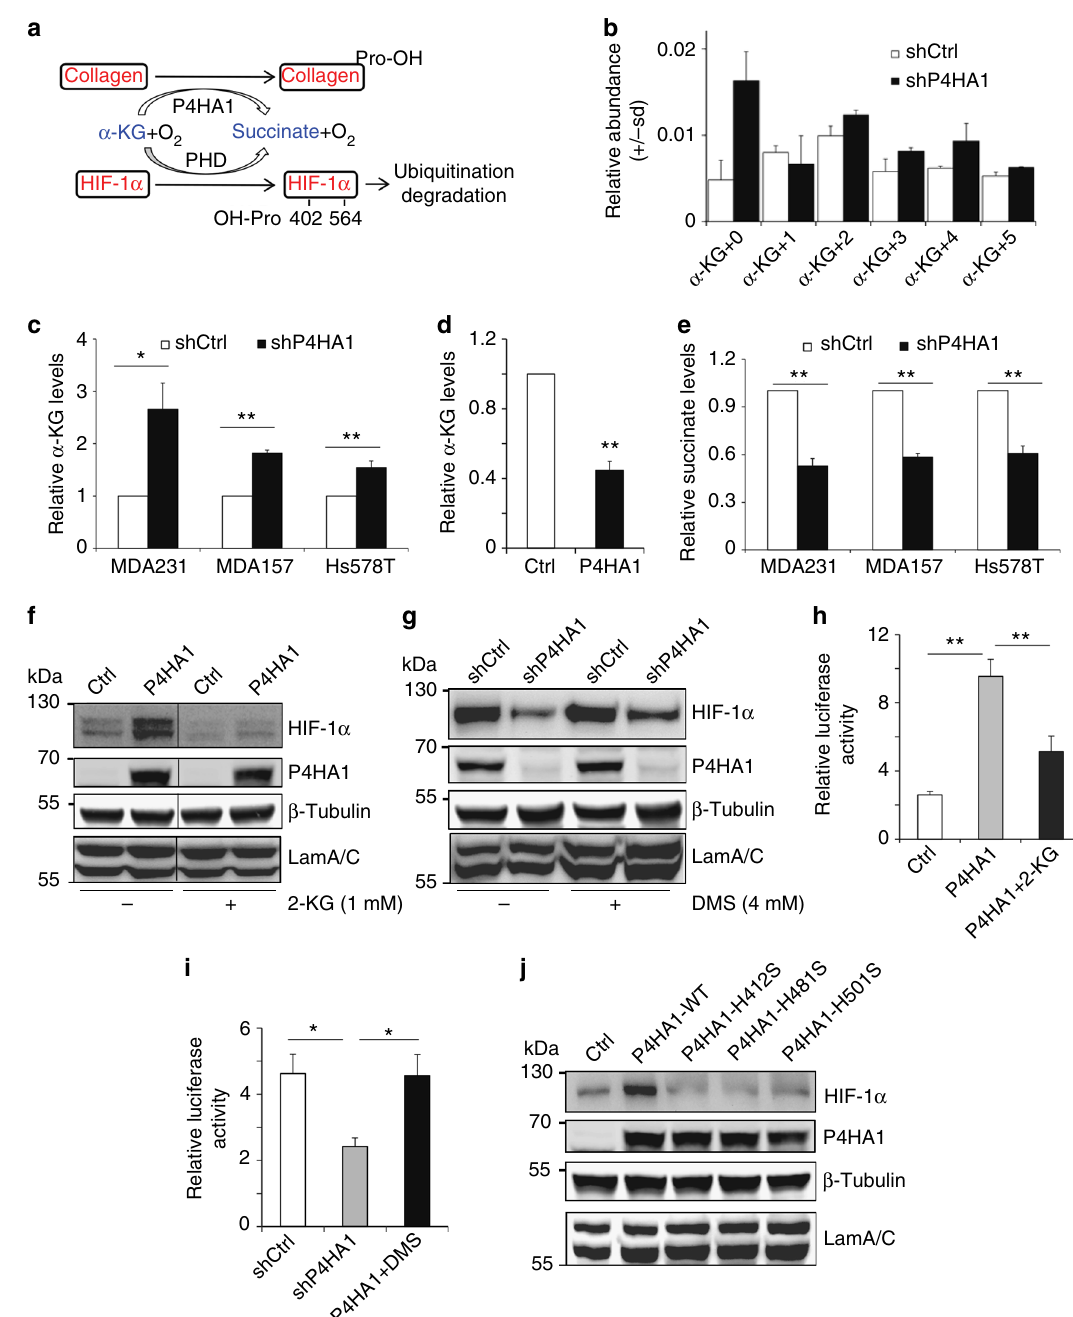
Fig. 4 P4HA1 enhances HIF-1 α stability by modulating α -KG l and succinate levels. a Scheme showing that HIF-1 α hydroxylation is regulated by oxygen tension and metabolites ( α -KG and succinate). b – d Cytoplasmic α -KG levels were measured in control, P4HA1-silenced MDA-MB-231, and P4HA1- expressing cells. Results are presented as mean ± SEM; n = 3; * p < 0.05, ** p < 0.01, independent Student ’ s t test. e Cytoplasmic succinate levels were measured in control and P4HA1-silenced MDA-MB-231 cells. Results are presented as mean ± SEM; n = 3; ** p < 0.01, independent Student ’ s t test. f , g HIF- 1 α protein levels were assessed in control, P4HA1-expressing MCF10A, and P4HA1-silenced cells in the presence or absence of octyl- α -ketoglutarate (1 mM) or dimethyl-succinate (4 mM). h , i ODD-luciferase reporter activity was measured in control, P4HA1-silenced, and P4HA1-expressing cells in the presence or absence of octyl- α -ketoglutarate (1 mM) or dimethyl-succinate (4 mM); n = 3, results are presented as mean ± SEM. * p < 0.05,